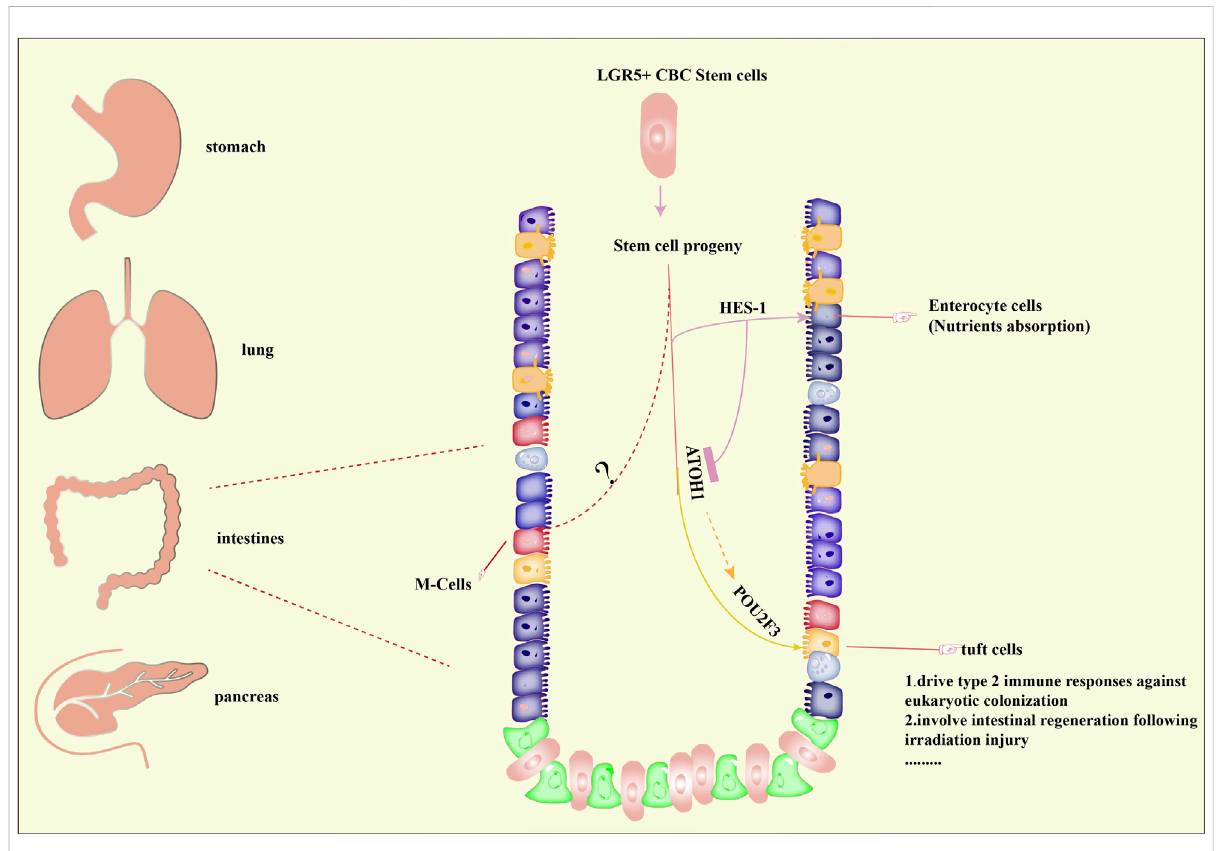
Distribution and formation of tuft cells. Tuft cells have been reported to be present in organs including the stomach, lung, intestine, pancreas. Theformationoftuftcellsinintestineshasbeenpredominantlystudiedandwellelucidated.Brie fl y,stemcellprogenitorsoriginatedfromLgr5+crypt base columnar (CBC) stem cells can differentiate into tuft cells under the control of atonal homologue 1 (ATOH1) and POU Class 2 Homeobox 3 (POU2F3), both of which are master regulators of tuft cells. On the other hand, hairy/enhancer of split 1 (HES1) directs the formation of enterocyte cells, which is important for nutrients absorption. However, the underlying mechanisms of M-cells formation remains unclear. Importantly, tuft cells are associated with type 2 immune responses and regeneration of